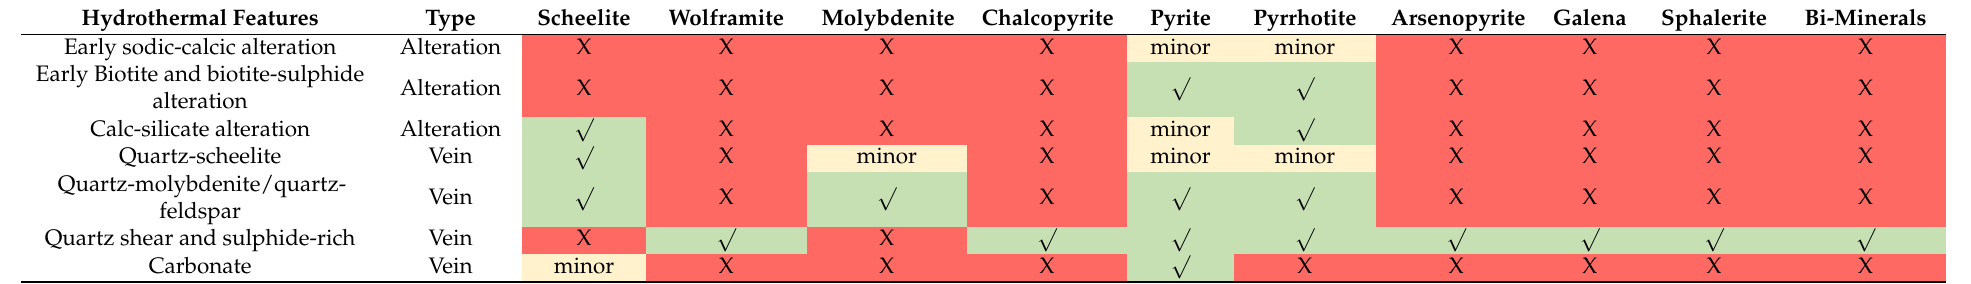
Table 1. Hydrothermal features associated with the mineralization at Sisson and the associated indicator minerals for each. Features are listed in order of decreasing age within each type, with the exception of calc-silicate alteration for which no age has been